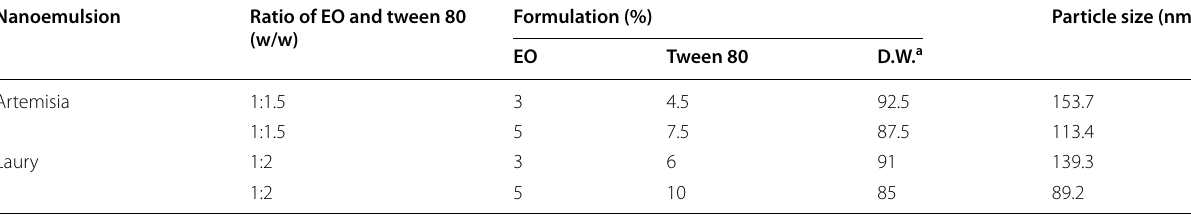
Table 3 Ratio of the components of the successful essential oils’ nanoemulsions